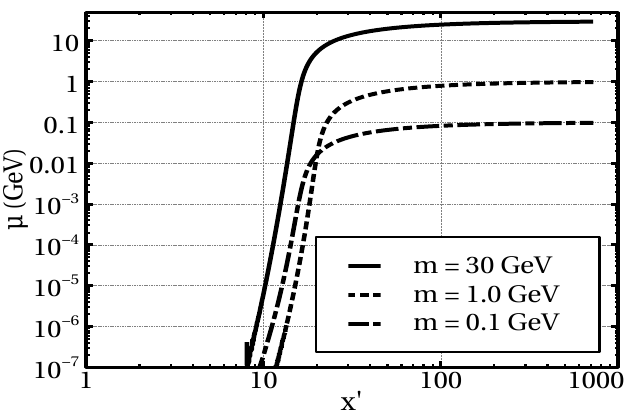
Figure 6 . Variation of chemical potential with x 0 for three different values of m